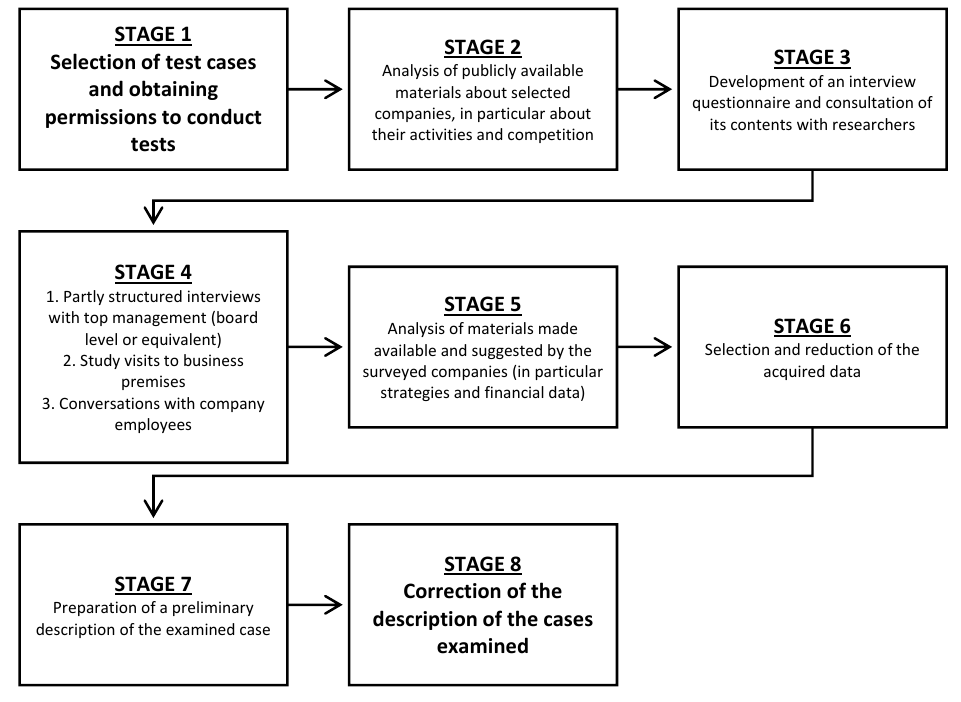
Figure 2. Case study framework.